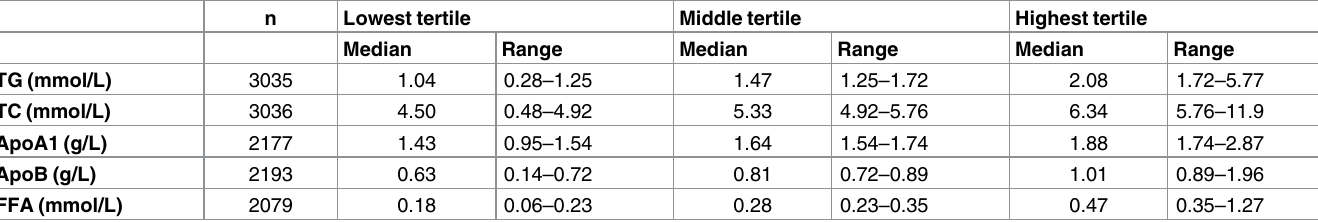
Table 2. Tertiles of the investigated